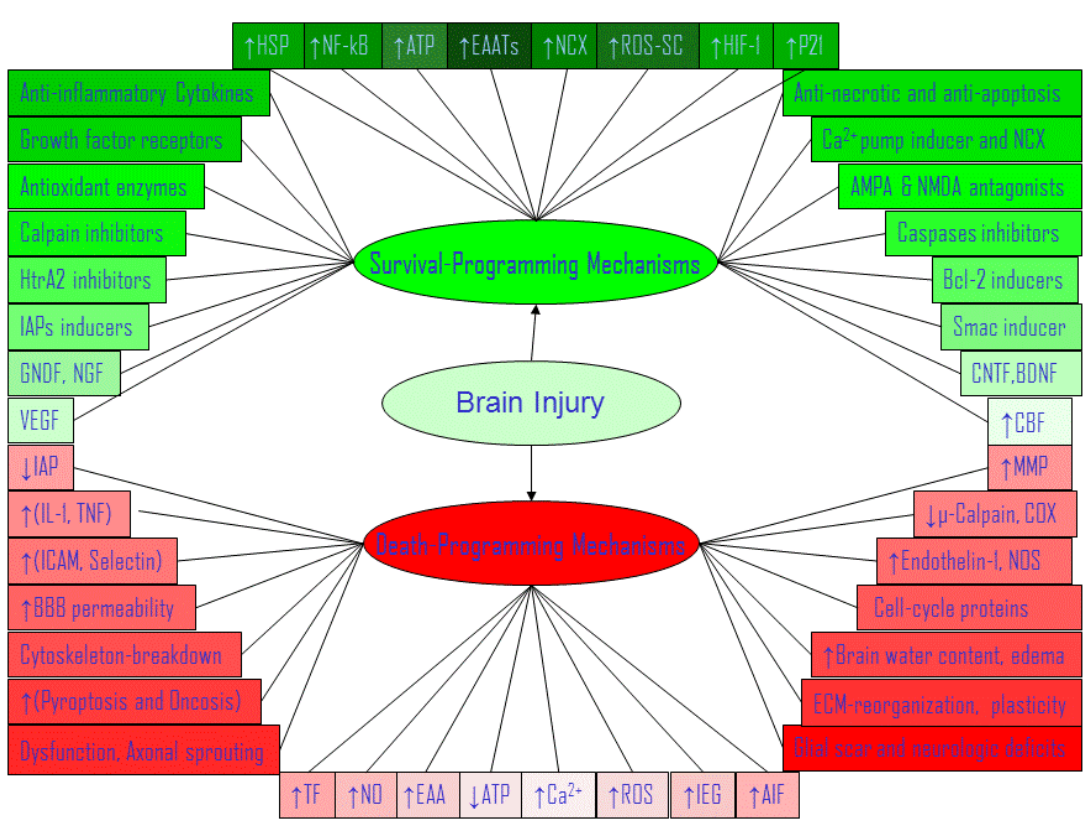
FIGURE 1. Temporal (color intensity) and schematic showing target events by which ischemia proteomics (brain injury) could either protect or enhance cell death dose dependently. Abbreviations: AIF, apoptosis- inducing factor; AMPA, α-amino-3-hydroxyl-5-methyl-4-isoxazole-propionate; ATP, adenosine triphosphate; BBB, blood brain barrier; BDNF, brain-derived neurotrophic factor; CBF, cerebral blood flow; IAPs, the inhibitor of apoptosis proteins, XIAP, cIAP-1, cIAP-2, and survivin; CNTF, ciliary neurotrophic factor; COX, cyclo-oxygenase; EAA, excitatory amino acid; EAAT, excitatory amino acid transporter; ECM, extracellular matrix; GDNF, glial cell line–derived neurotrophic factor; HIF-1, hypoxia- inducible factor-1; HSP, heat shock protein; HtrA2, the mature serine protease Omi; ICAM, intracellular adhesion molecule-2; IEG, immediate early gene; IL-1, interleukin-1; MMP, matrix metalloproteinase; NCX, Na-Ca exchanger; NF-κB, nuclear factor-kappa B; NGF, nerve growth factor; NMDA, N-methyl-D- aspartic acid; NO, nitric oxide; NOS, nitric oxide synthase; P21, potent cyclin-dependent kinase